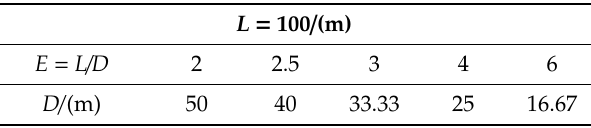
Table 1. Values of L , e , and D